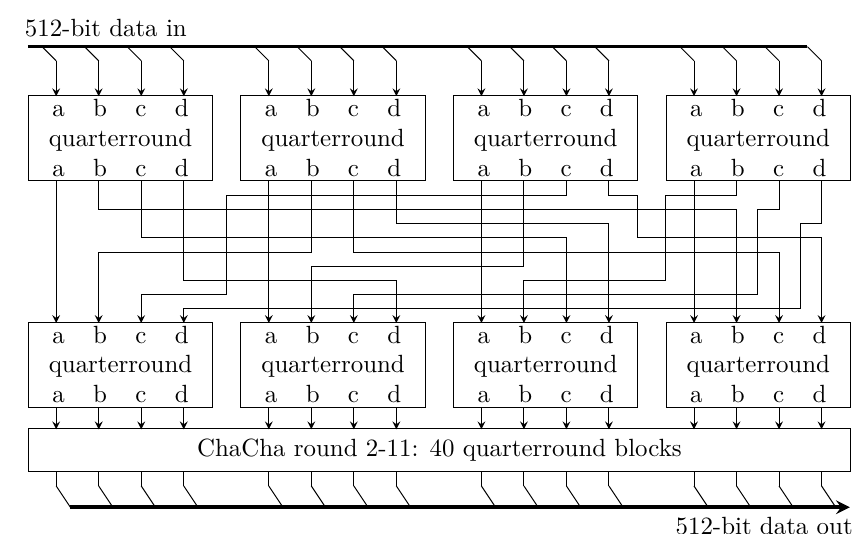
Figure 5: The ChaCha12 pipeline instantiates the quarterround block 48